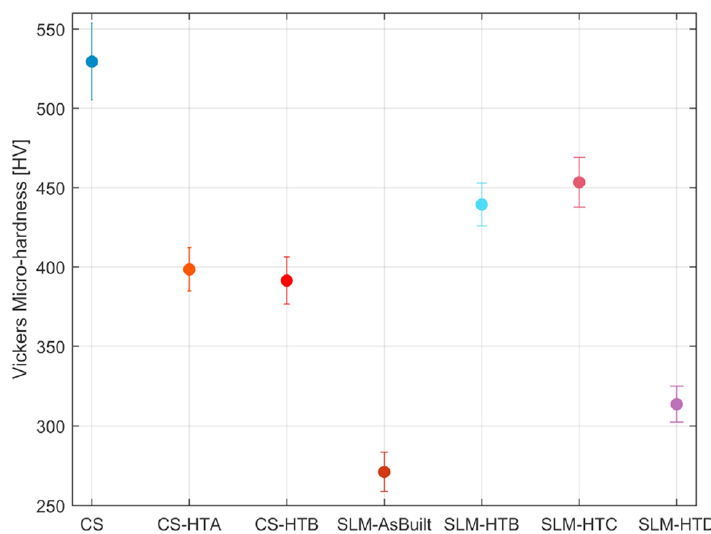
Figure 14. A comparative viewing of the micro-hardness measurements from pre- and post-heat- treated CS and SLM IN 718 substrates. Reprinted from Bagherifard et al. [96], Copyright 2018, with permission from Elsevier.